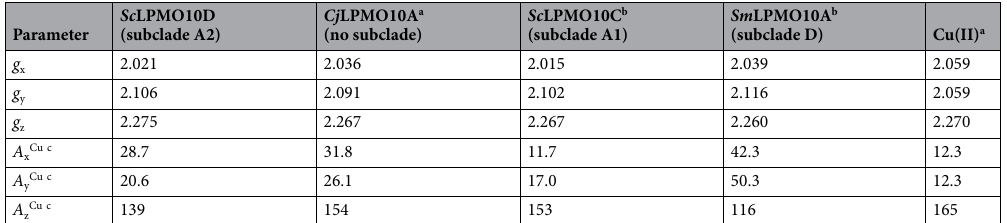
Table 2. Comparison of LPMO Spin hamiltonian parameters. Assuming collinear g - and A Cu —tensors in all simulations. a Data from a previous study by Forsberg et al . 44 . b Data from a previous study by Forsberg et al . 56 . c (10 –4 cm −1